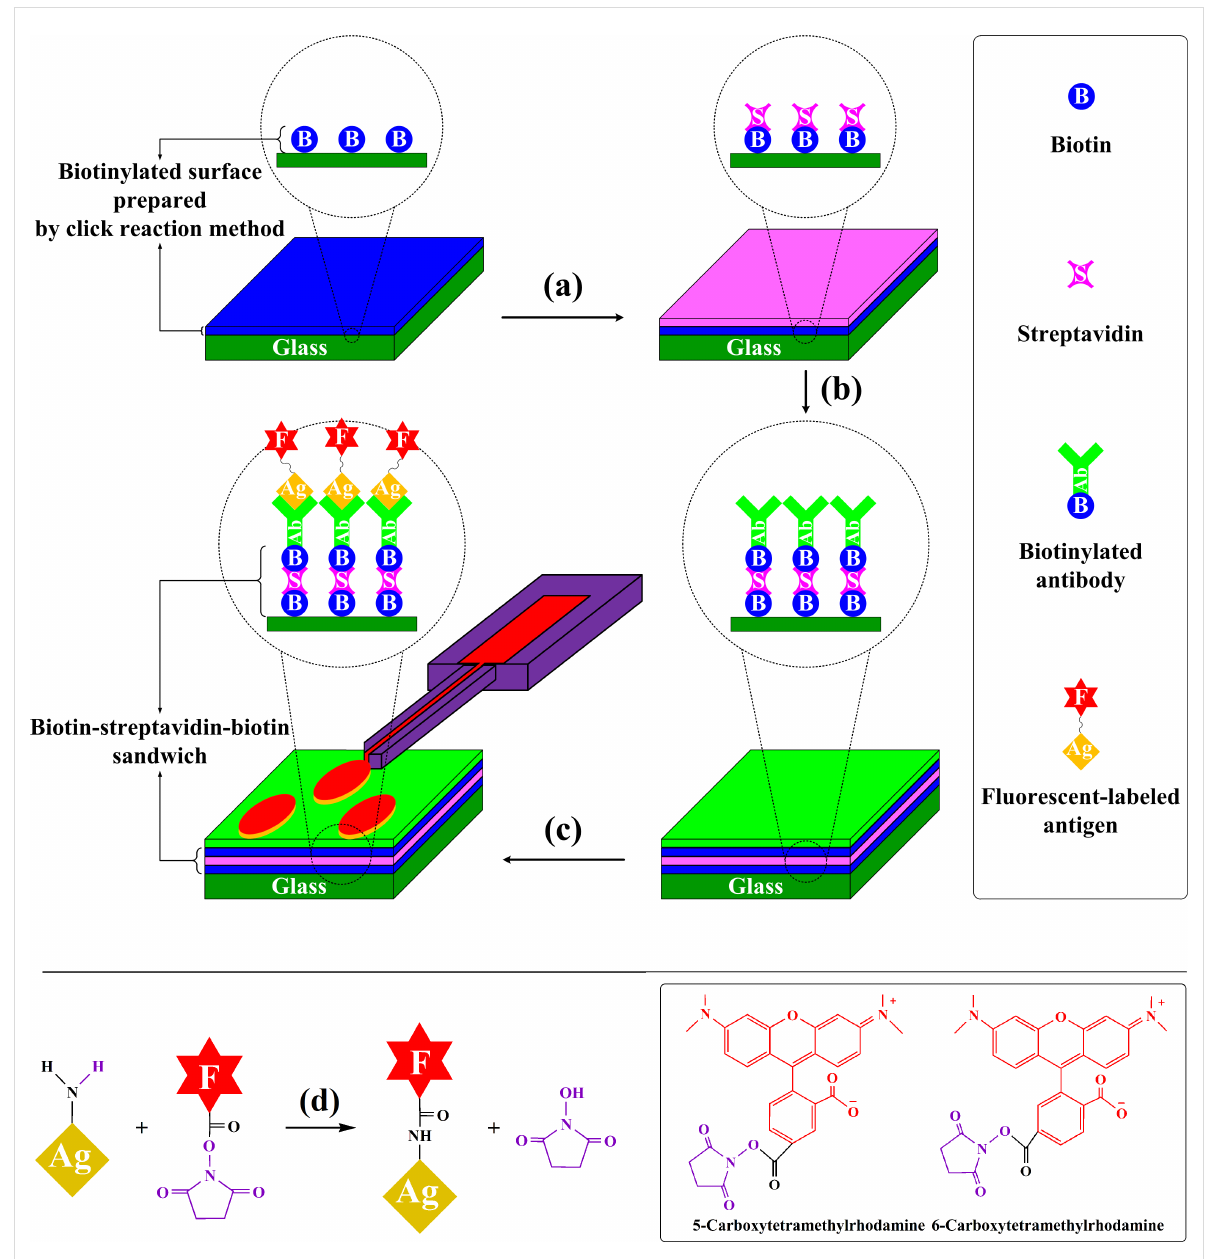
Figure 3: Schematic of the microarrays prepared for AFP detection. a) Incubating biotinylated surfaces with streptavidin solution, b) reaction of the streptavidin on the surface with the biotinylated anti-AFP, c) delivery of fluorescently labeled AFP via µCS, and d) preparation of fluorescently labeled AFP through the reaction between the NHS-ester reagent (NHS–rhodamine) and the primary amine of the antigen (AFP).